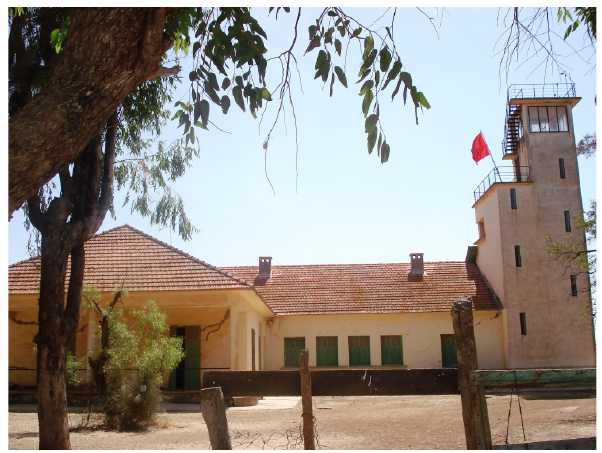
Figure 2. Main building of the Averroes Observatory at Berrechid.